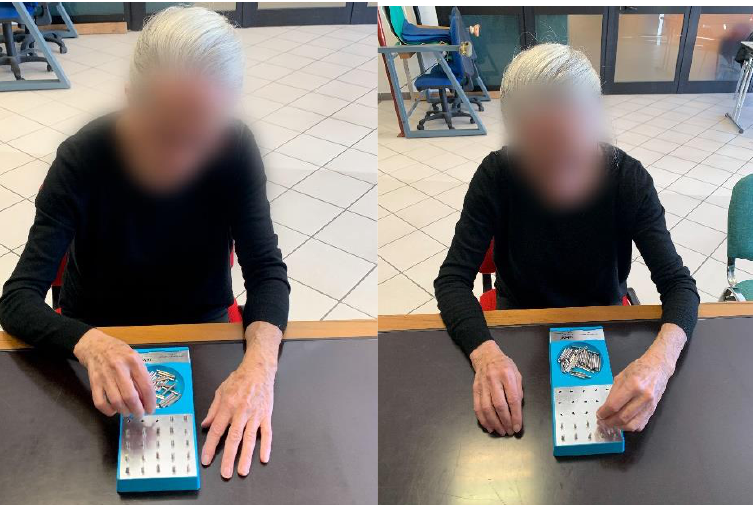
Figure 3. Standard Grooved Pegboard test position.